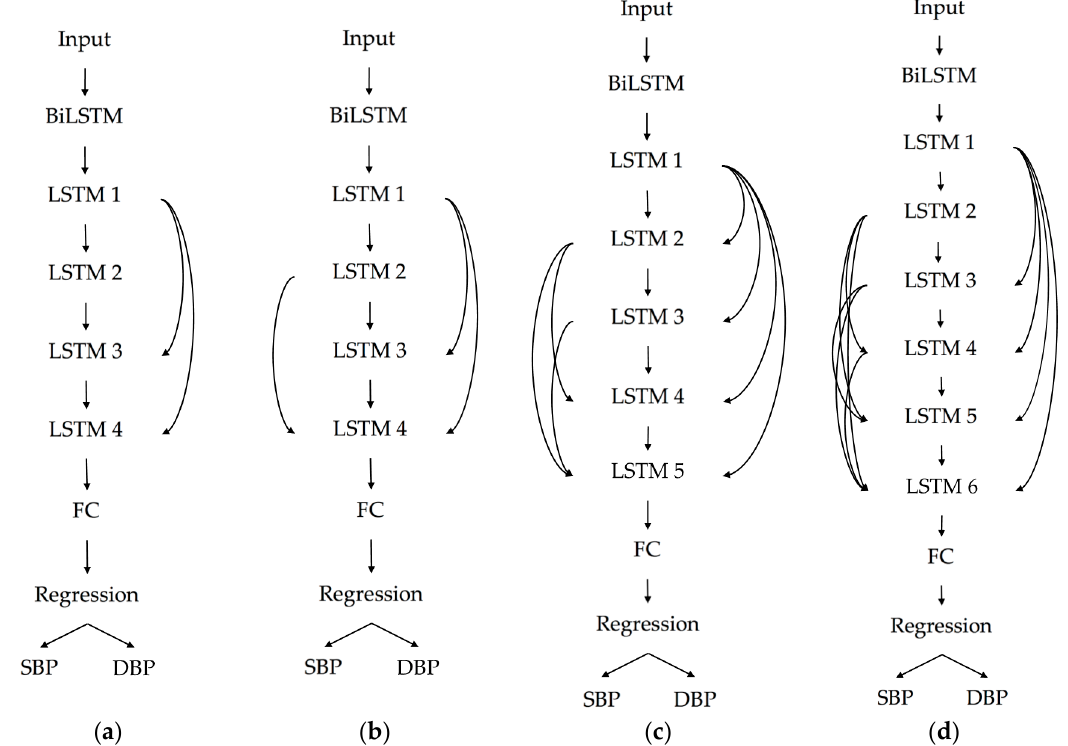
Figure 8. The proposed models: ( a ) Model 1, ( b ) Model 2, ( c ) Model 3, and ( d ) Model 4.